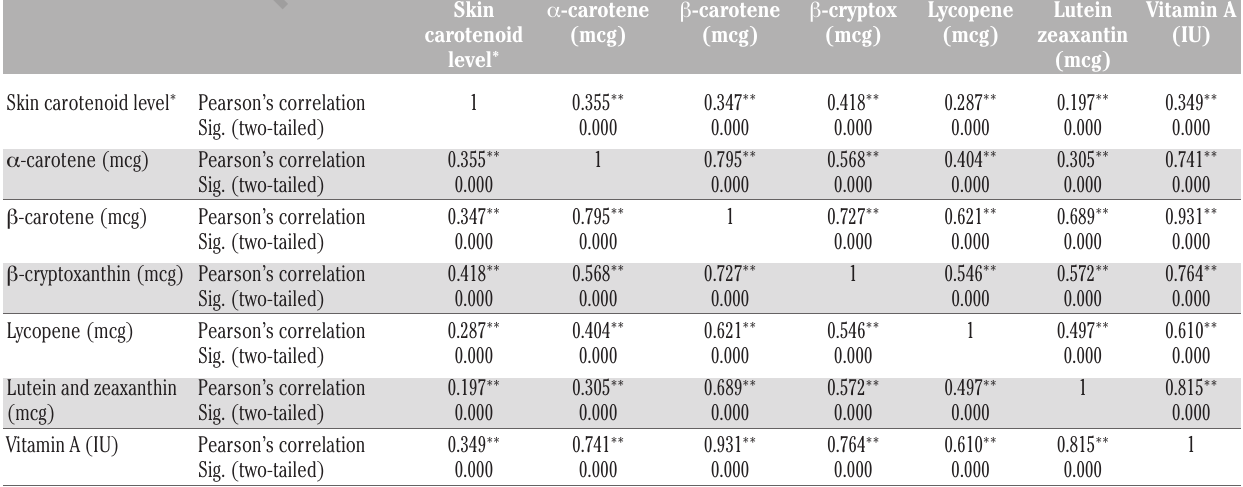
Table 3. Correlation among skin carotenoids level and carotenoid intake.